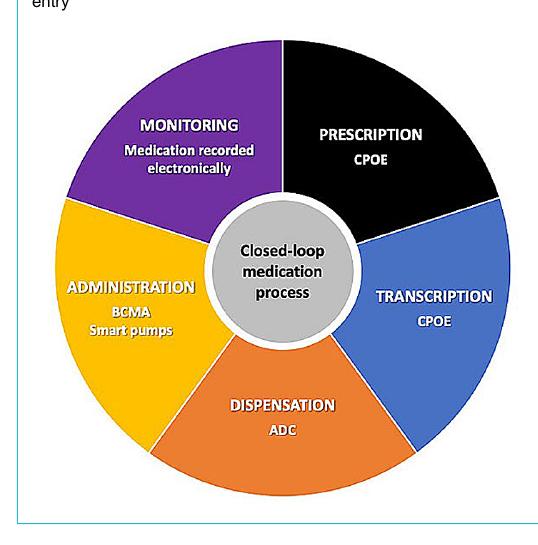
Figure 1: Closed-loop medication management process. This process completely encloses, supports and secures the medica- tion process using digital eHealth technologies. Adapted from [5]. ADC = automated dispensing cabinet; BCMA = bar-coded medica- tion administration; CPOE = computerised provider/physician order